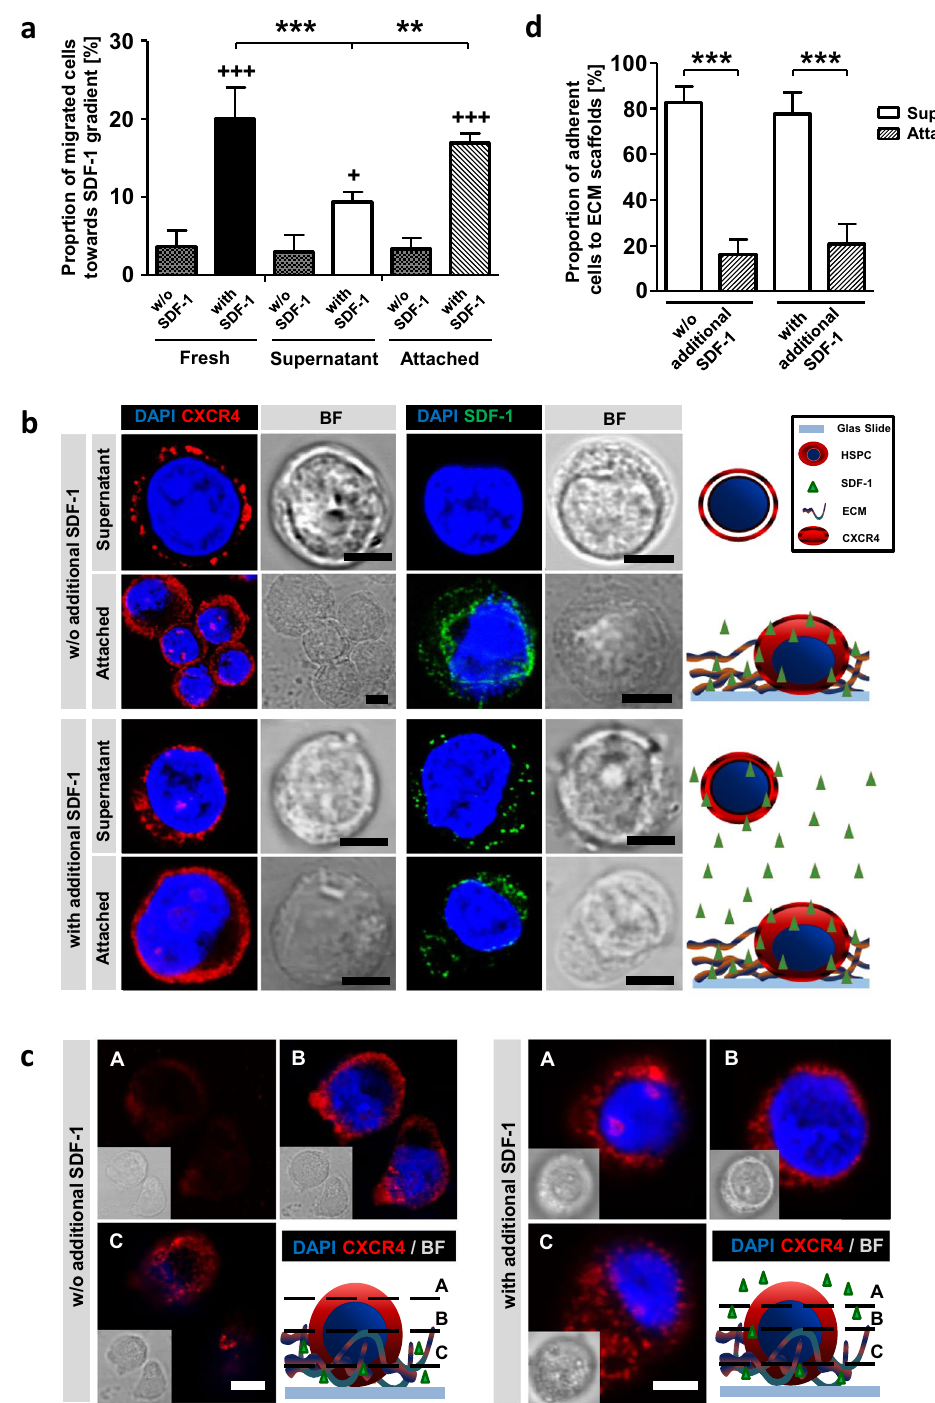
Figure 3. SDF-1/CXCR4 axis is active on ECM cultured HSPCs. ( a ) Proportion of migrated fresh-, SN- and AT-cells in a trans-well migration assay towards SDF-1 containing medium (with SDF-1) or towards SDF-1 free medium (spontaneous migration, w/o SDF-1). n = 4, two-tailed t-test; * = significance in comparison to SN-cells and + = significance in comparison to corresponding w/o SDF-1. ( b ) Confocal microscopy images of CXCR4 (red) or SDF-1 (green) staining and nuclear DAPI (blue) staining. Cells were treated with medium either without (w/o) or with additional SDF-1. Schemas show technique and findings. Bars = 5 µ m. ( c ) Confocal microscopy z-stack images of α -CXCR4 (red) and nuclei DAPI (blue) staining. A = top, B = middle and C = bottom of cells. Cells were treated with medium either without or with additional SDF-1. Schemas show technique and findings. Bars = 5 µ m. ( d ) Proportion of cell adhesion to ECMs 24 hours after seeding either without or with additional SDF-1 containing medium. n = 6 for w/o additional SDF-1, n = 3 for with additional SDF-1, two-tailed t-test. Error bars, SD.; * p < 0.05, ** p < 0.01, *** p <